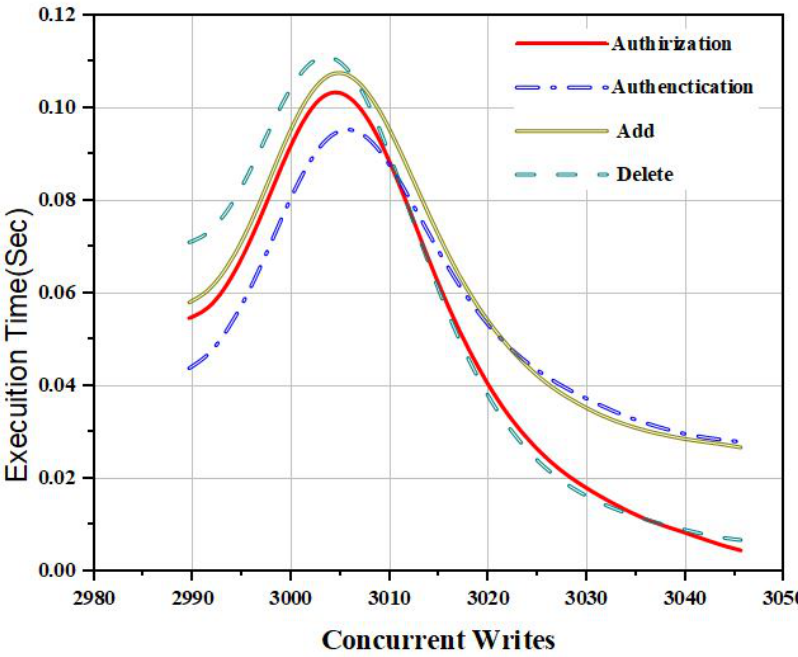
Figure 6. Comparative analysis of different domains based on homomorphic encryption and se- cure searchable.